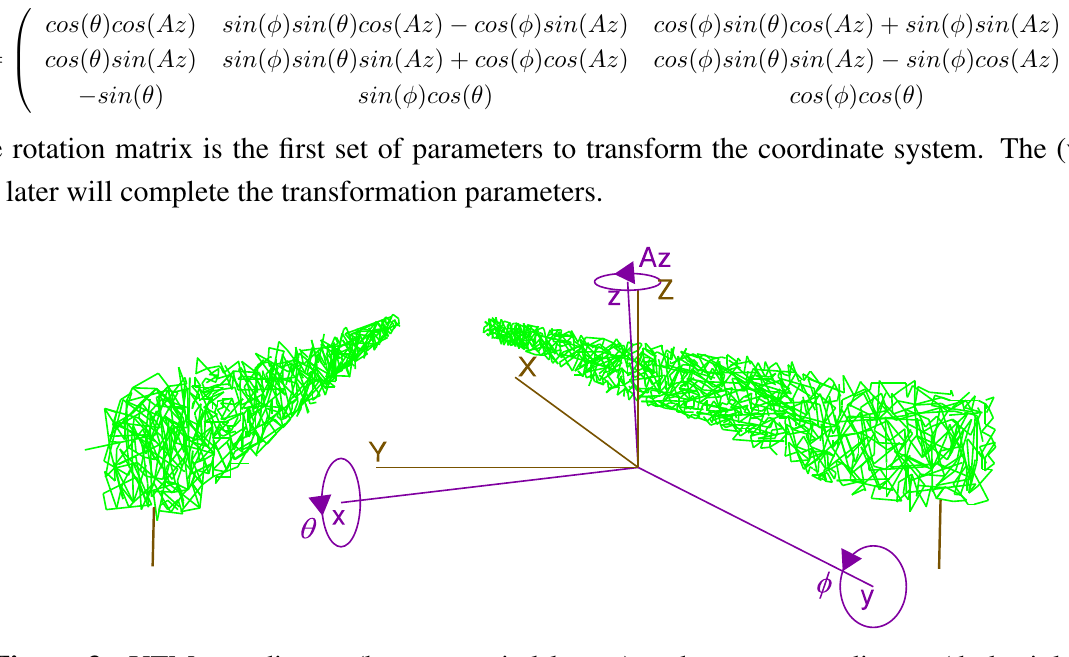
Figure 3. UTM coordinates (brown, capital letters) and system coordinates (dark violet, lower case letters). Rotations Az , φ and θ transform a vector from system orientation to absolute (UTM)